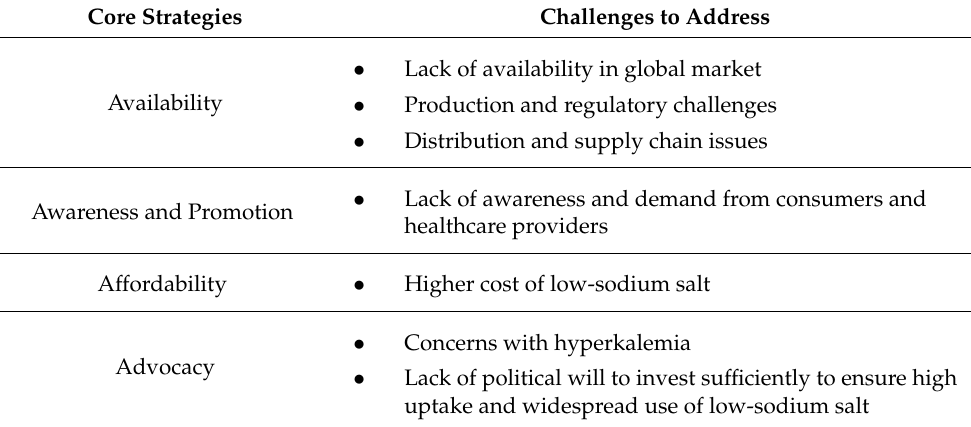
Table 2. Framework for addressing challenges to scale up low-sodium salt